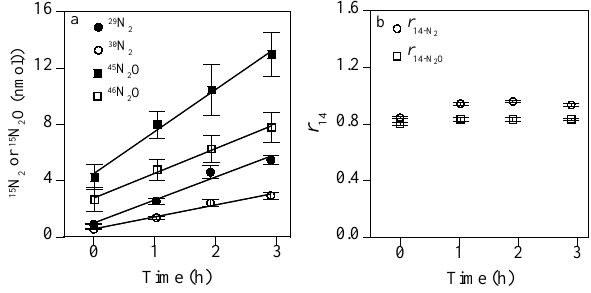
931 Fig. 6. Results from time series experiment. (a) Production of 15 N 2 Figure 6. Results from time series experiment. (a) Production of 15 N 2 and 15 N 2 O as a 932 and 15 N 2 O as a function of time. Regression coefficients ( r 2 ) are function of time. Regression coefficients (r 2 ) are 0.97, 0.98, 0.99 and 0.99 for 29 N 2 , 933 0.97, 0.98, 0.99 and 0.99 for 29 N 2 , 30 N 2 , 45 N 2 O and 46 N 2 O, re- 30 N 45 N 46 N spectively. (b) Observational r 14 − N 2 , 2 O and 2 O, respectively. (b) Observational r 14-N 2 and r 14-N 2 O values as a 934 tion of time. Values are means ± 1 SEM ( n = 3). function of time. Values are means ± 1 SEM (n = 3). 935